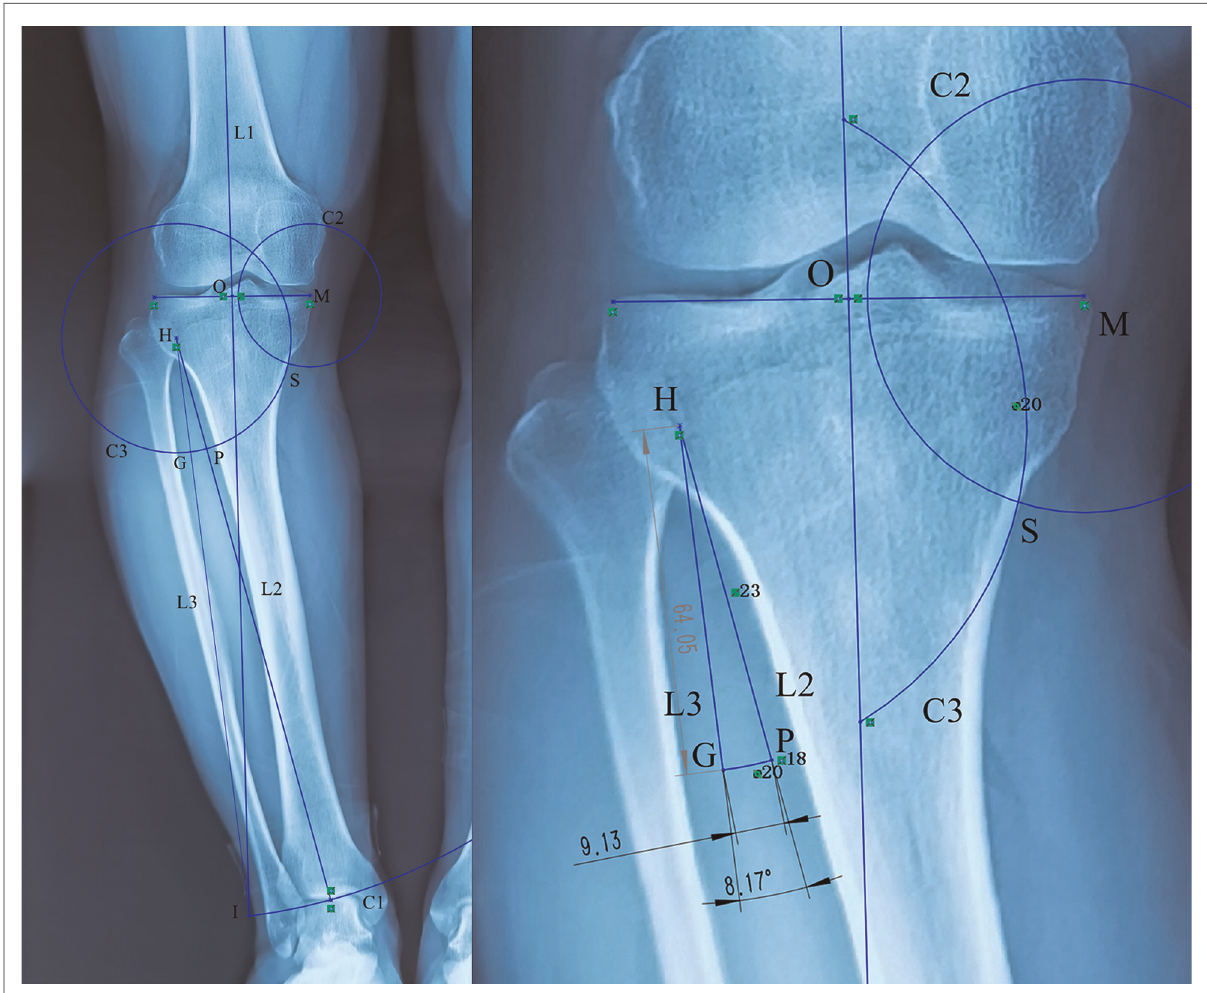
FIGURE 4 The H point was used as the center, and the distance from the H point to the ankle joint center (L2) was used as the radius to draw a concentric circle, L1 intersected at the I point, and line segment HI (L3) was drawn. The angle formed by L2 and L3 indicates the correction angle. Taking point H as the center, HS was used as the radius to draw a concentric circle that intersected L2 at point P and L3 at point G, while the length of the line segment PG indicated the length of the correction